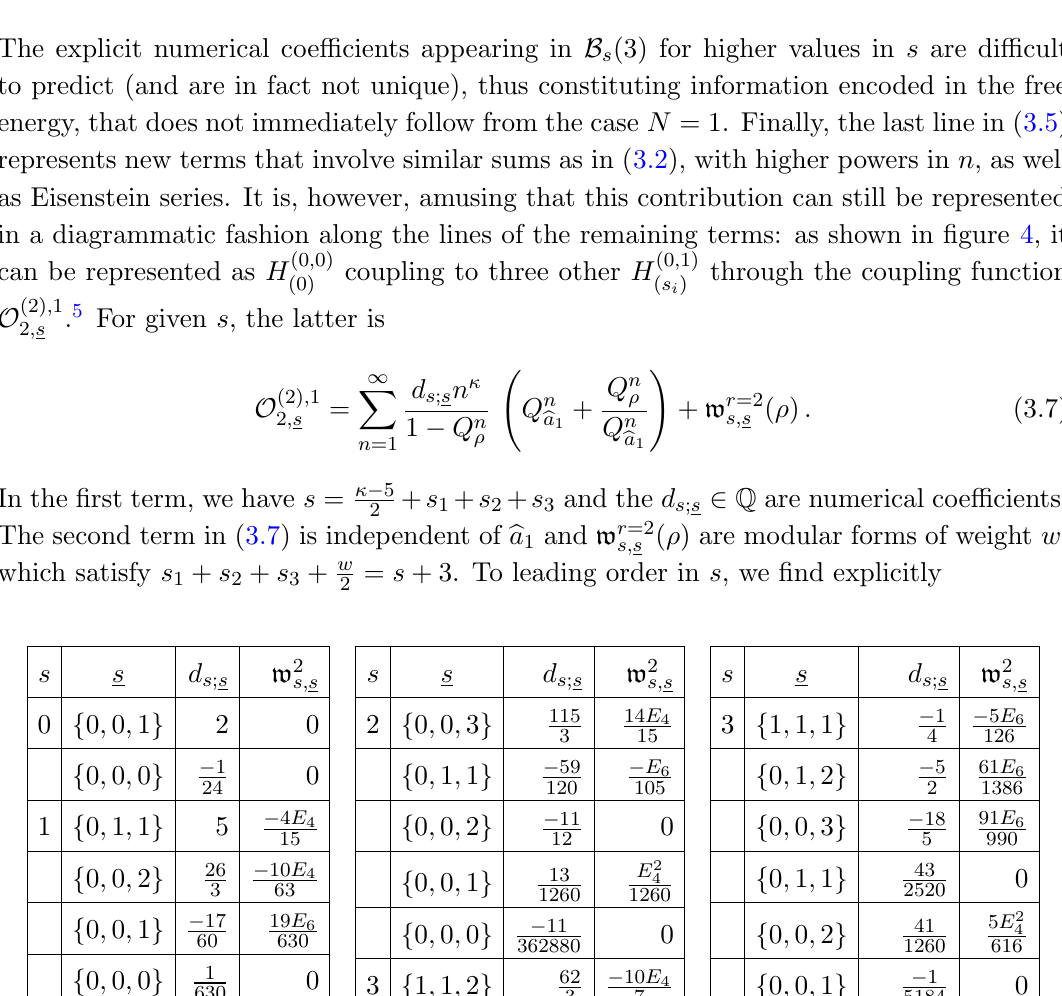
to three H (1 ; 2) through O (2) ; 1 2 ;s (0) ( s i )